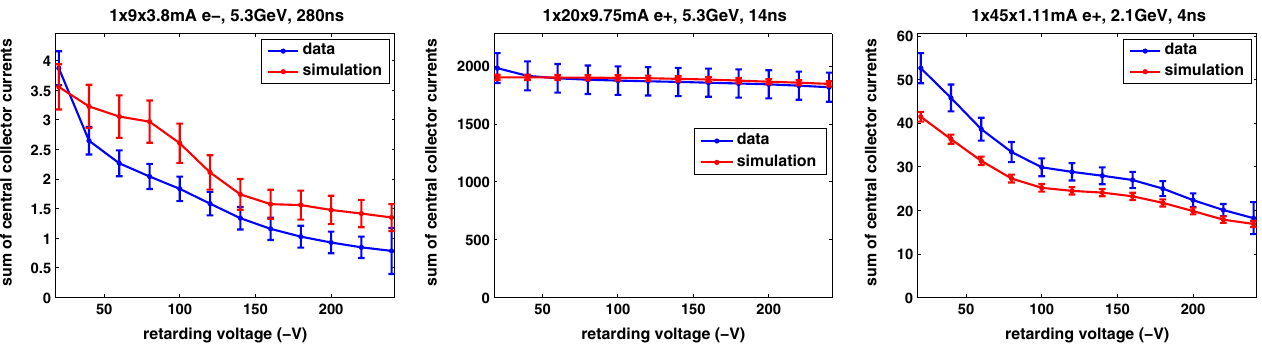
FIG. 10. Comparison of Q15W TiN RFA data and simulation, using best fit parameters (Table VII). The RFA is “ thin ” style (Table II). The plots show the signal in the central three collectors vs retarding